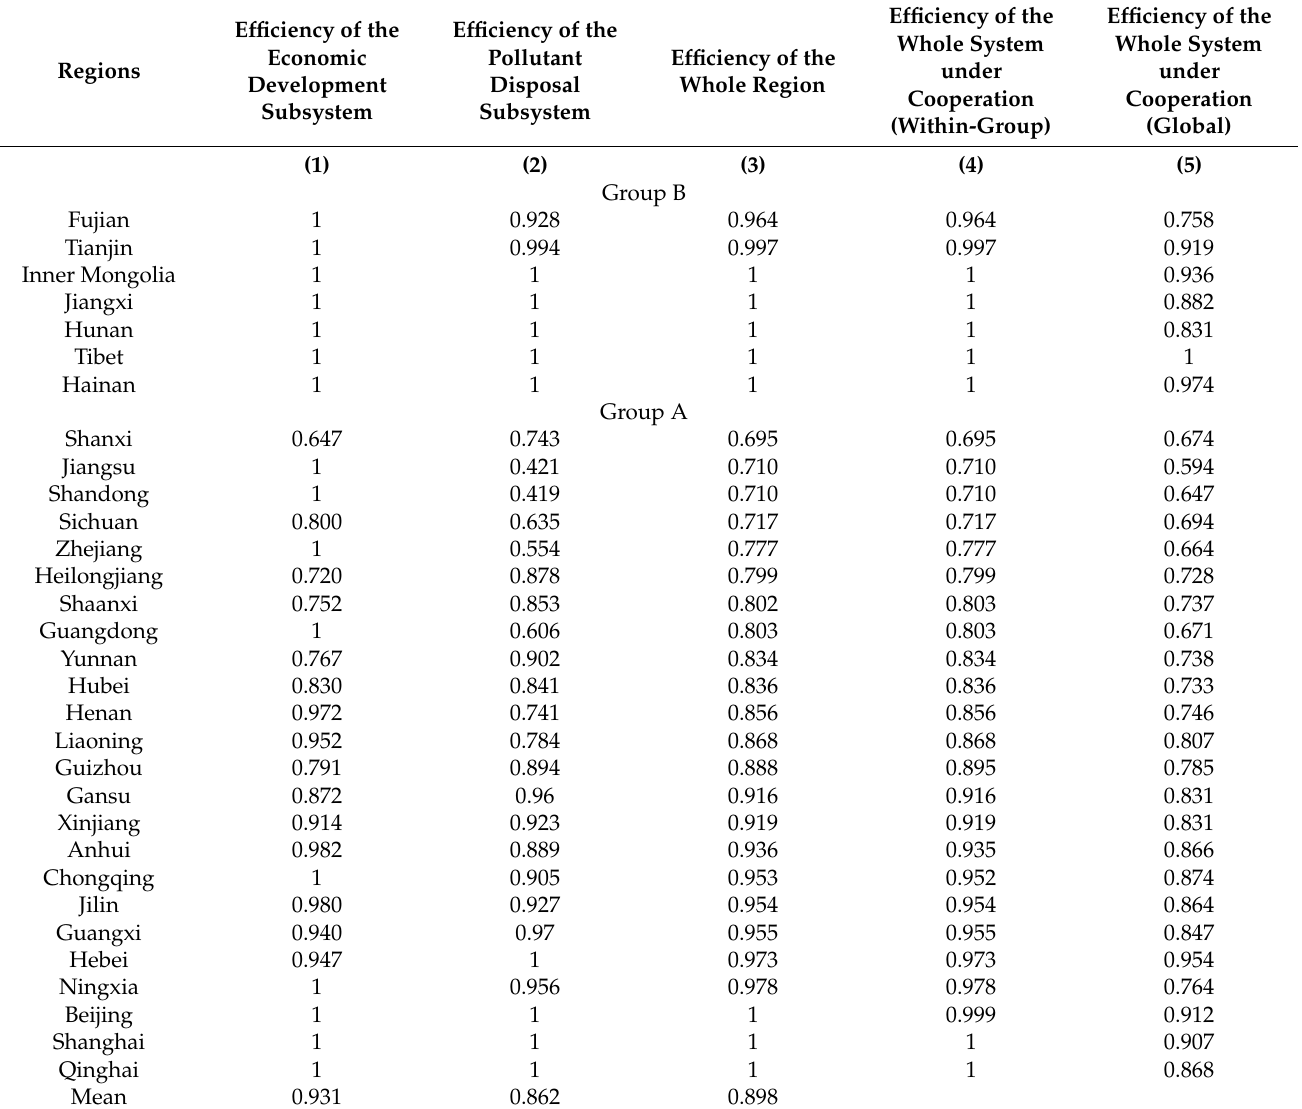
Table 3. The efficiencies of the subsystems and the whole